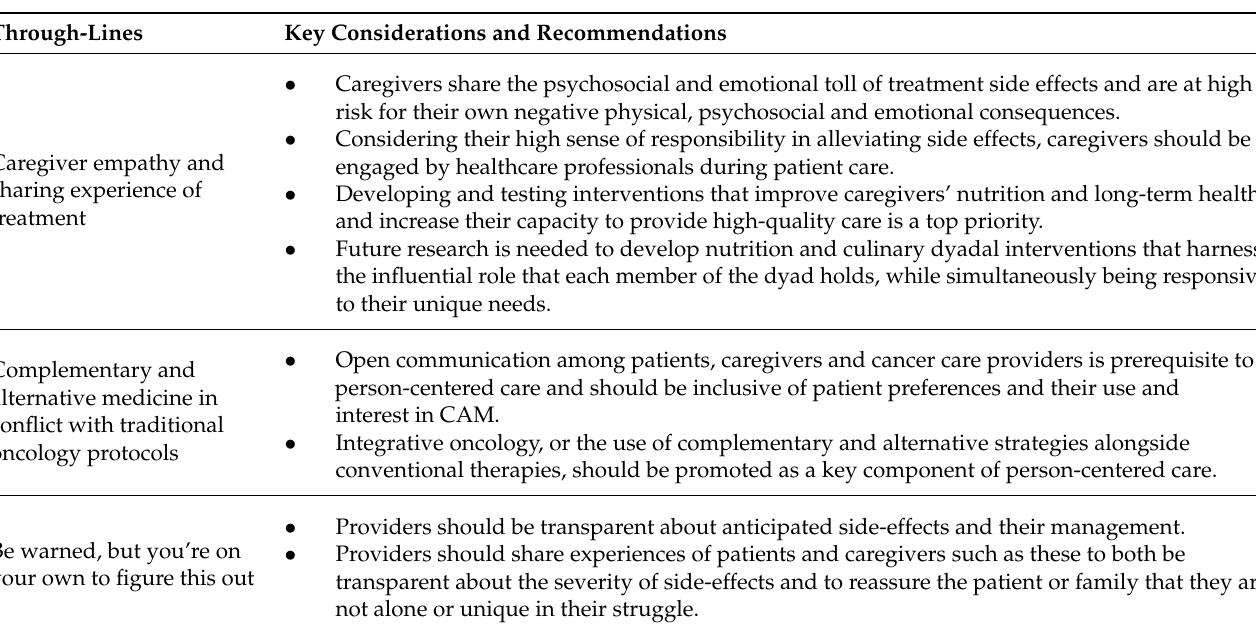
Table 5. Key Considerations and recommendations to improve person-centered